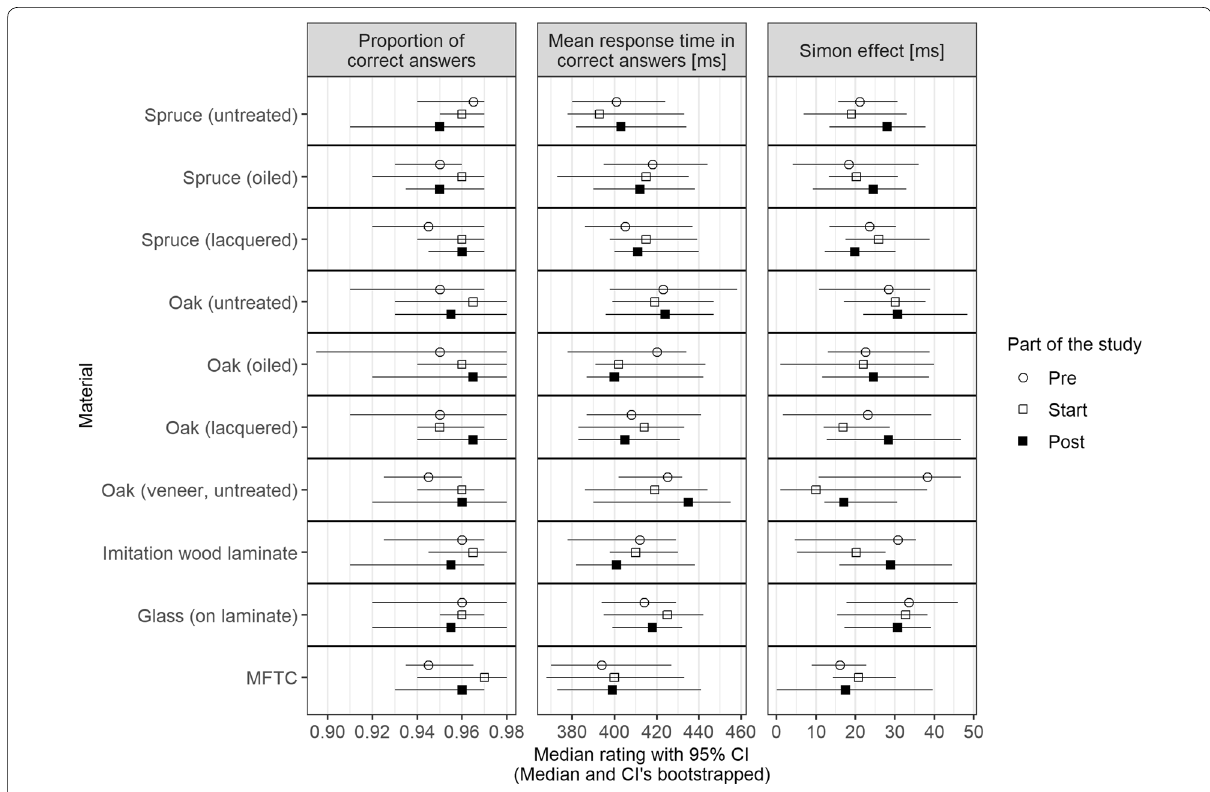
Fig. 7 Simon task outcomes grouped by materials and measurement time